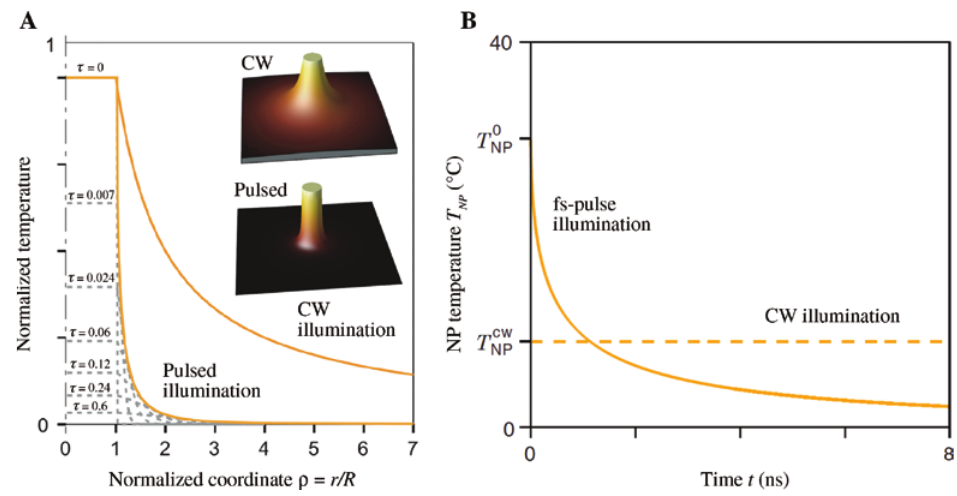
Figure 2: The modes of laser heating of Au NP in water. (A) Spatial extension of the temperature profile in CW and pulsed modes of laser irradiation. The normalised time τ = t/ τ pulsed irradiation. Insets, 3D representation of the temperature profile around plasmonic NP under CW and single fs-laser pulse irradiation. (B) Comparison of the time-dependent temperature behaviour for the CW (dashed line) and single-pulse illumination (solid line) modes. Reprinted with permission from [28, 37]. Copyright 2013 by Wiley-VCH Verlag GmbH & Co. KGaA, Weinheim; Copyright 2011 American Physical